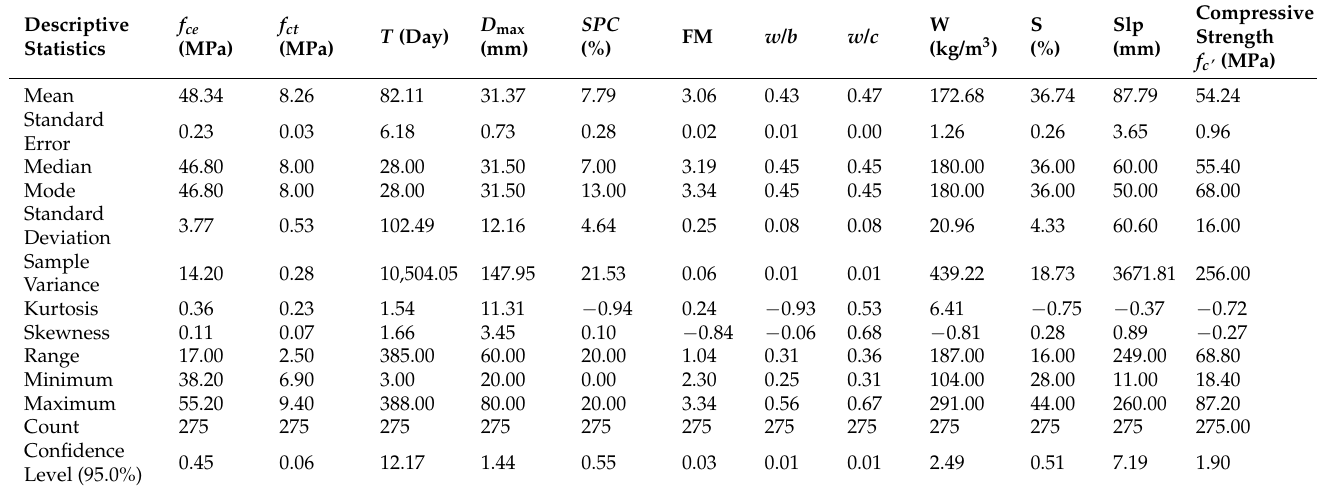
Table 1. Descriptive statistics of the input data used for the development of